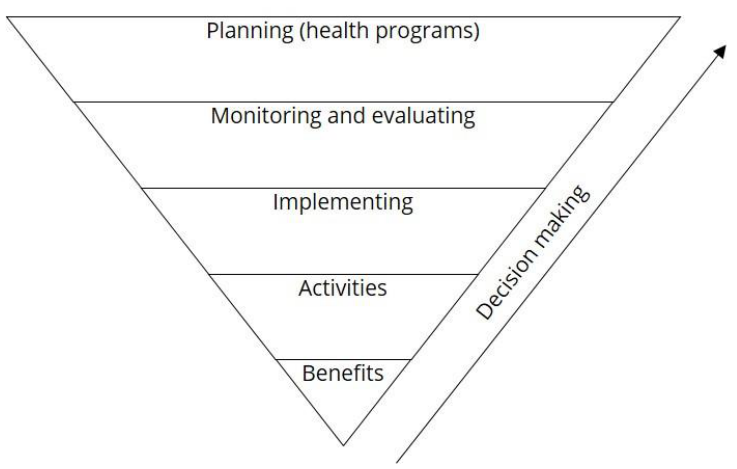
Source: Rifkin (1986, p. 247)